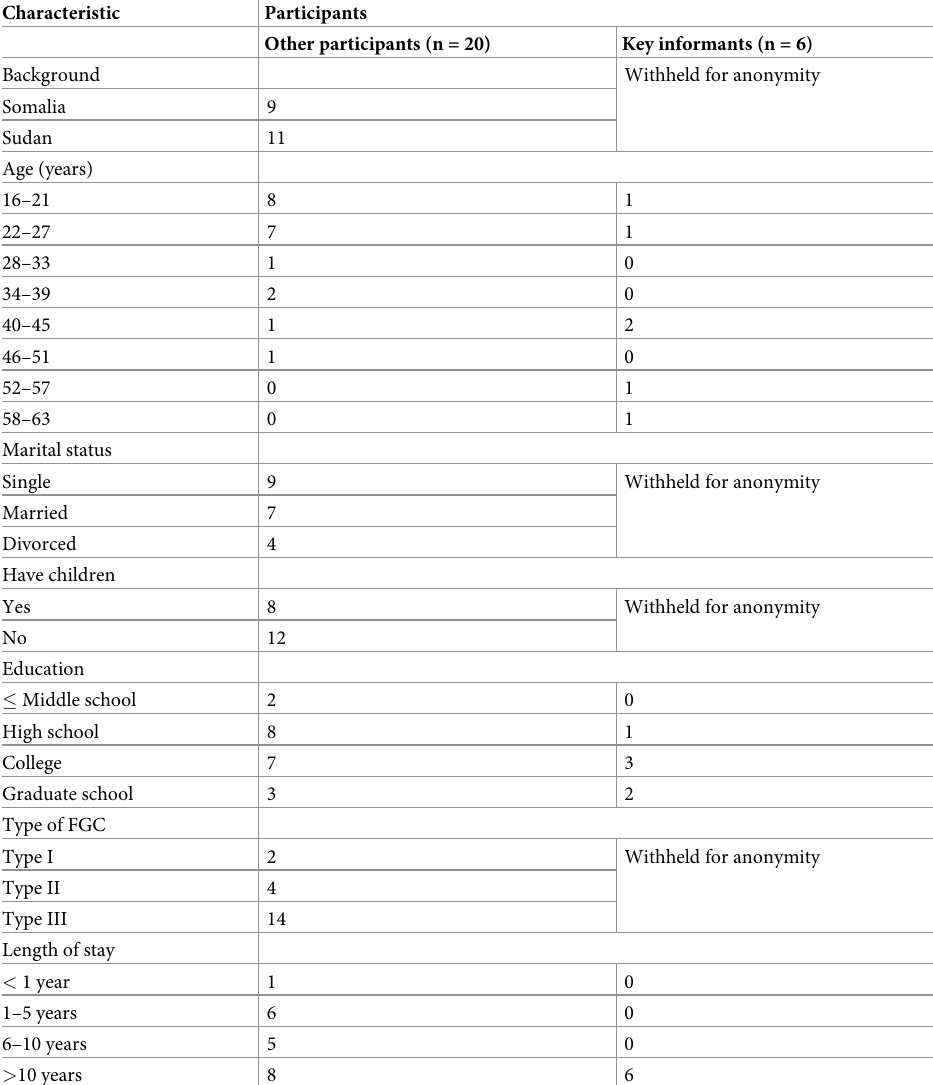
Table 1. Overview of participants’